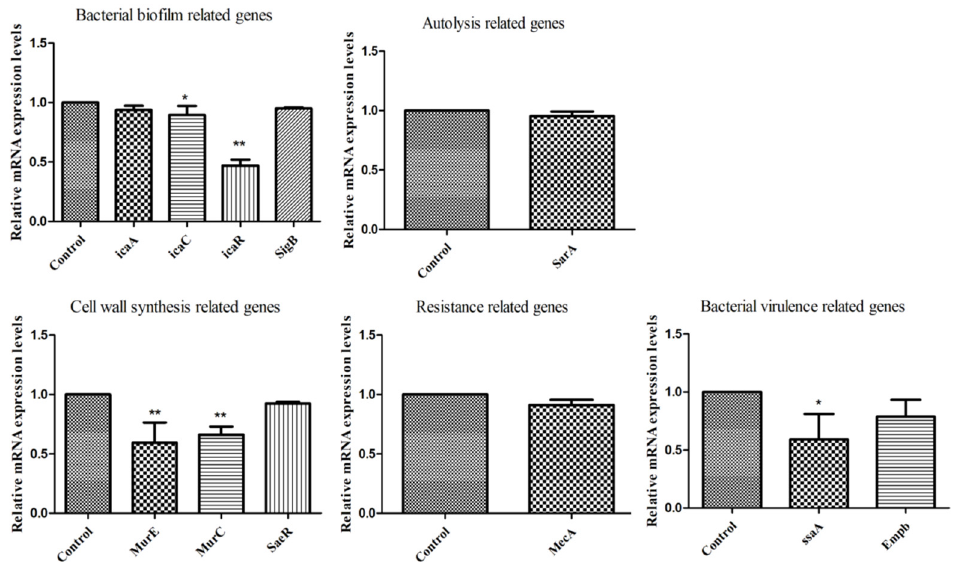
Figure 8. Gene expression of MRSA after exposure to RPE by real-time quantitative reverse transcription PCR (bacterial biofilm-related genes: icaA , icaC , icaR , SigB ; autolysis-related gene: SarA ; cell wall synthesis-related genes: MurE , MurC , SaeR ; resistance-related gene: MecA ; bacterial virulence-related genes: ssaA , Empb ). All data are presented as mean values ± SD, and n = 3 in each group. * p < 0.05, ** p < 0.01, vs. the solvent control.